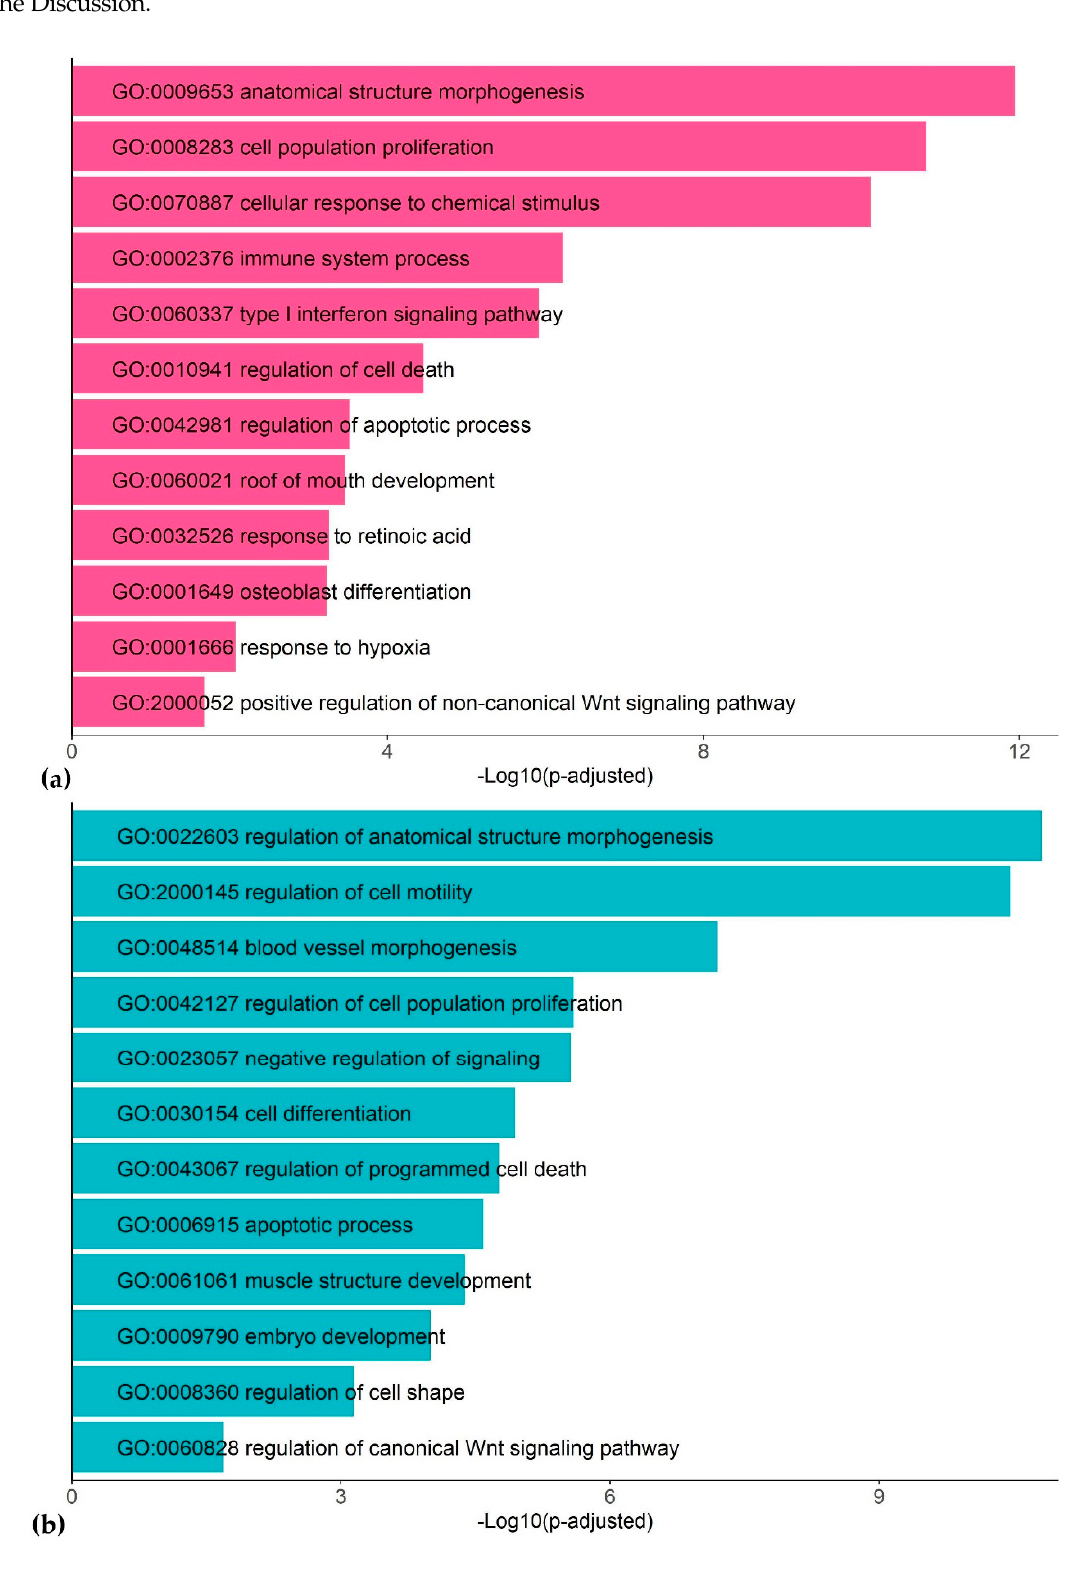
Figure 2. Representative gene ontology (GO) terms associated with TCDD response in human cell lines: up-regulated genes ( a ) and down-regulated genes ( b ).